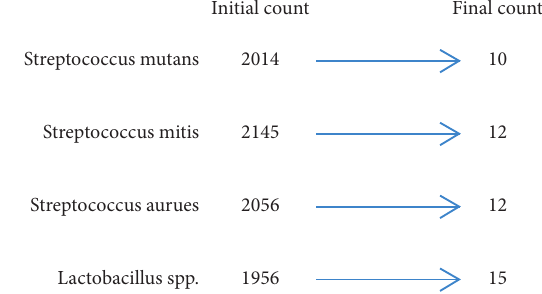
Figure 3: Bacterial count for experimental composite.